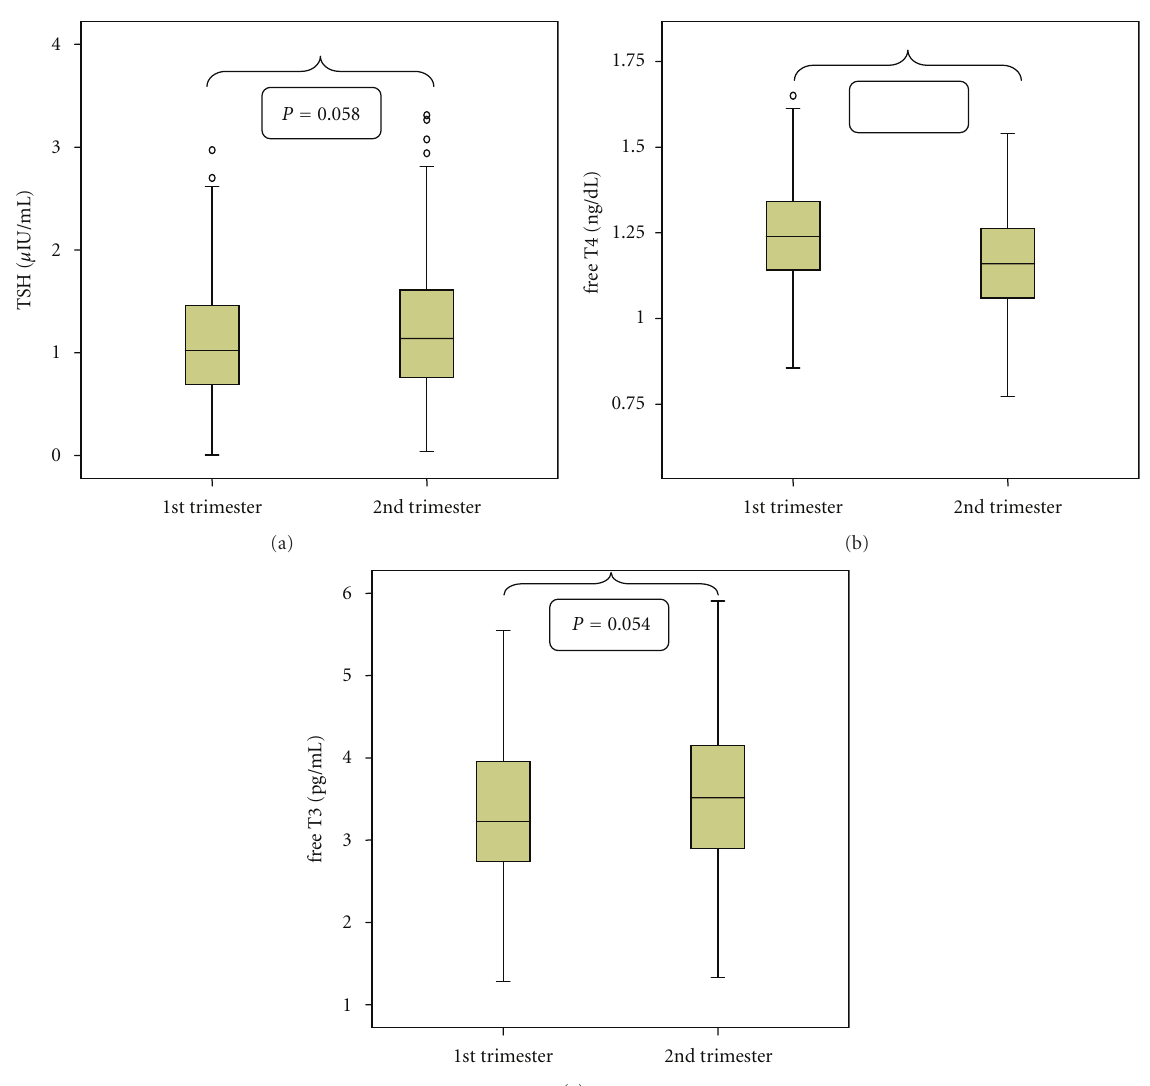
Figure 2: Box plot of TSH, free T3, and free T4 concentrations in the reference population during the 1st and 2nd trimester of gestation. TSH: thyroid-stimulating hormone; Free T3: free triiodothyronine; free T4: free thyroxine Di ff erences between first and second trimester are shown with P values ( P = 0 . 058 for TSH, P = 0 . 054 for free T3, P < 0 . 001 for free